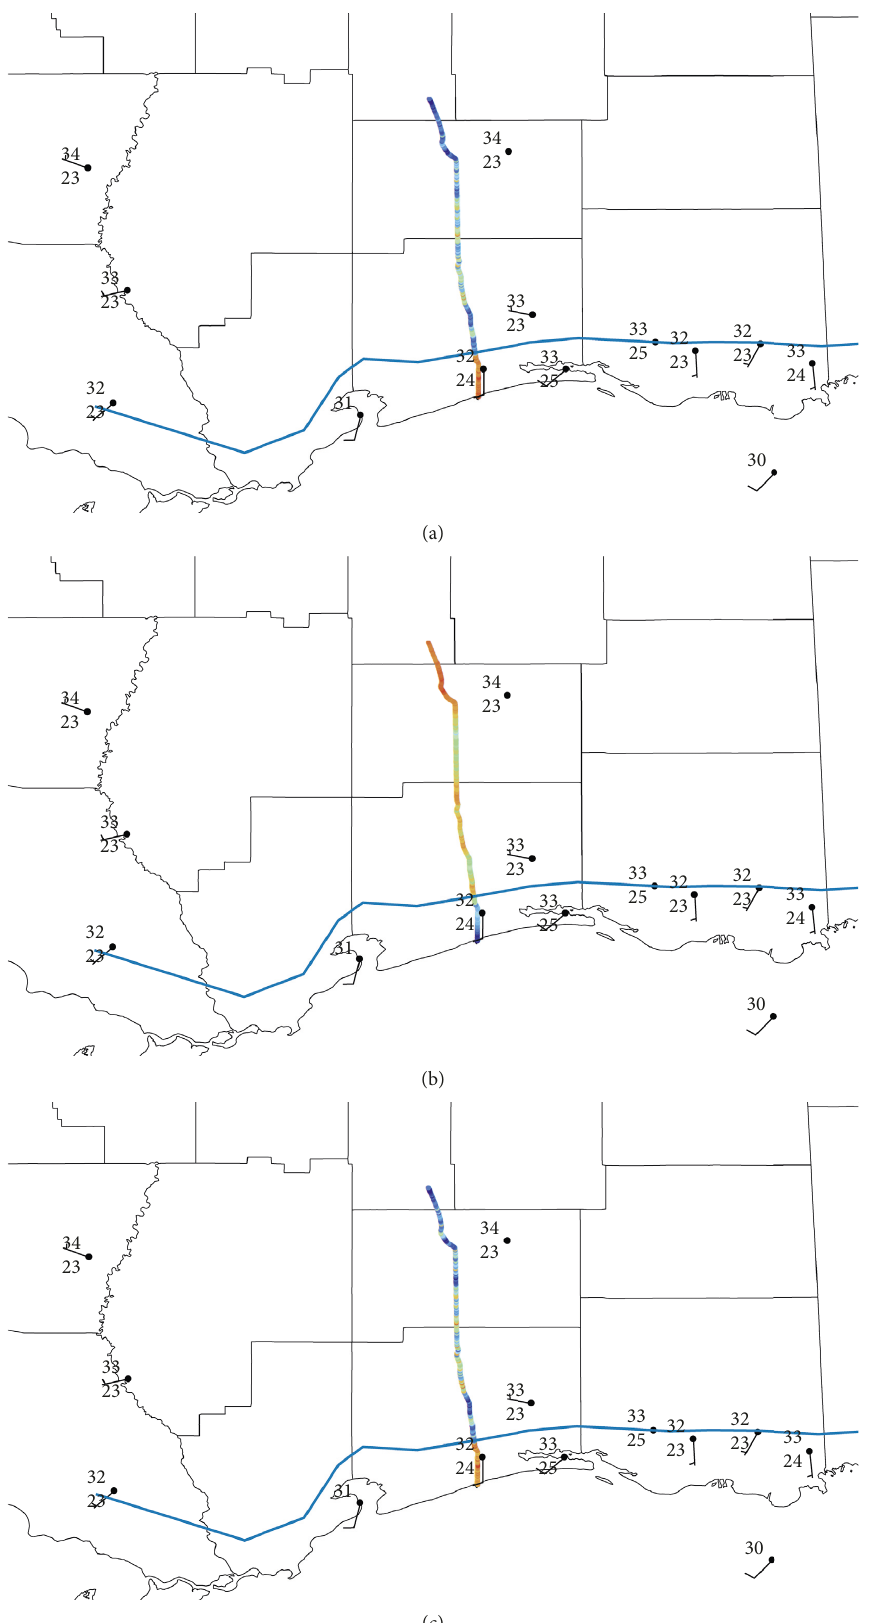
Figure 10: Map views of 6 August 2014 transect data in relation to temporally interpolated 1830 UTC (1330 CDT) station observations and position of the SBF from radar data. (a) Mixing ratio. (b) Virtual potential temperature. (c) Equivalent potential temperature (station model as in Figure